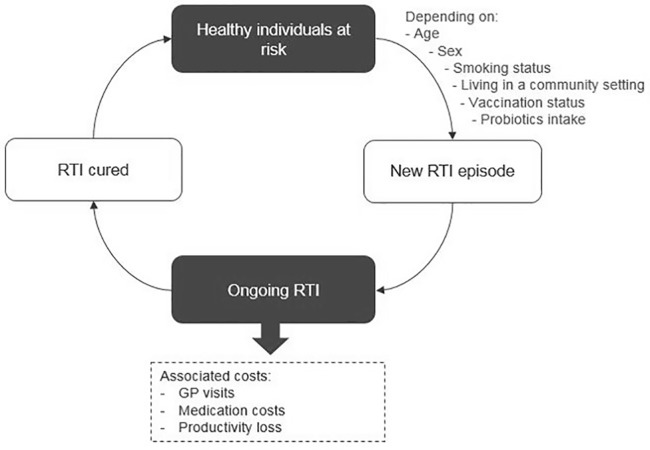
Model structure.